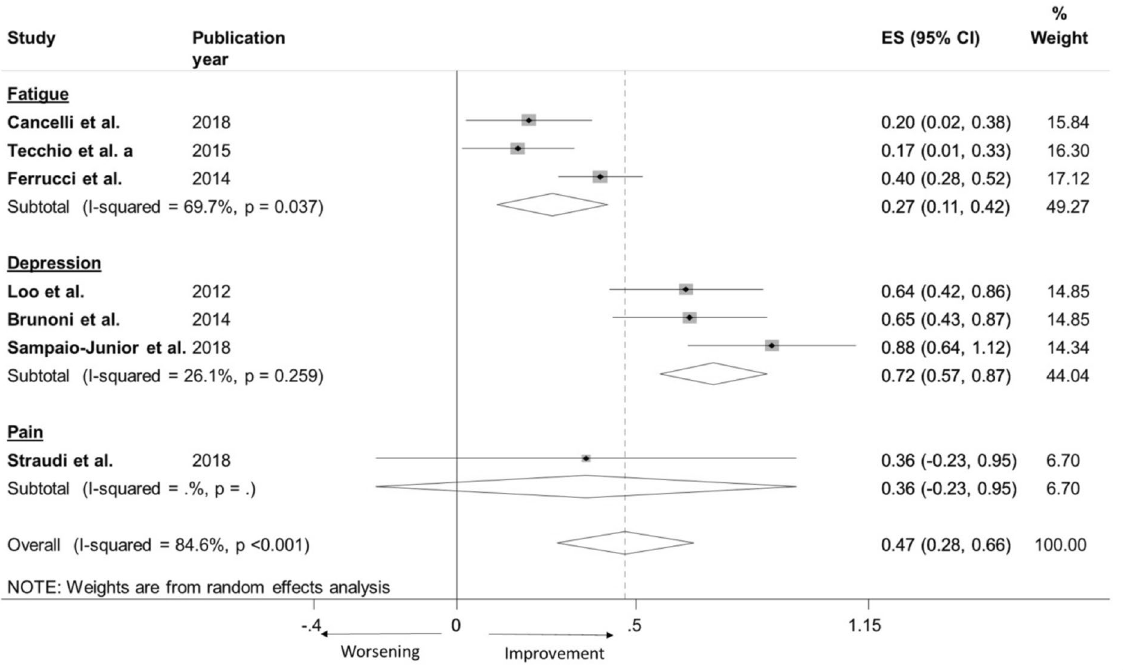
Figure 10. Estimation of Sham effect. ( a ) Forest plot of meta-analysis results considering all studies by pathology (MS fatigue, Depression, Pain). The diamond represents the pooled standardized mean difference (SMD, dashed red vertical line) and its 95% confidence interval; vertical solid dark line is the line of equivalence. The estimates for each study and their 95% confidence intervals are represented by a box with whiskers, the dimension of grey box is proportional to the precision of the study. Note: ES = Effect Size. CI = Confidence